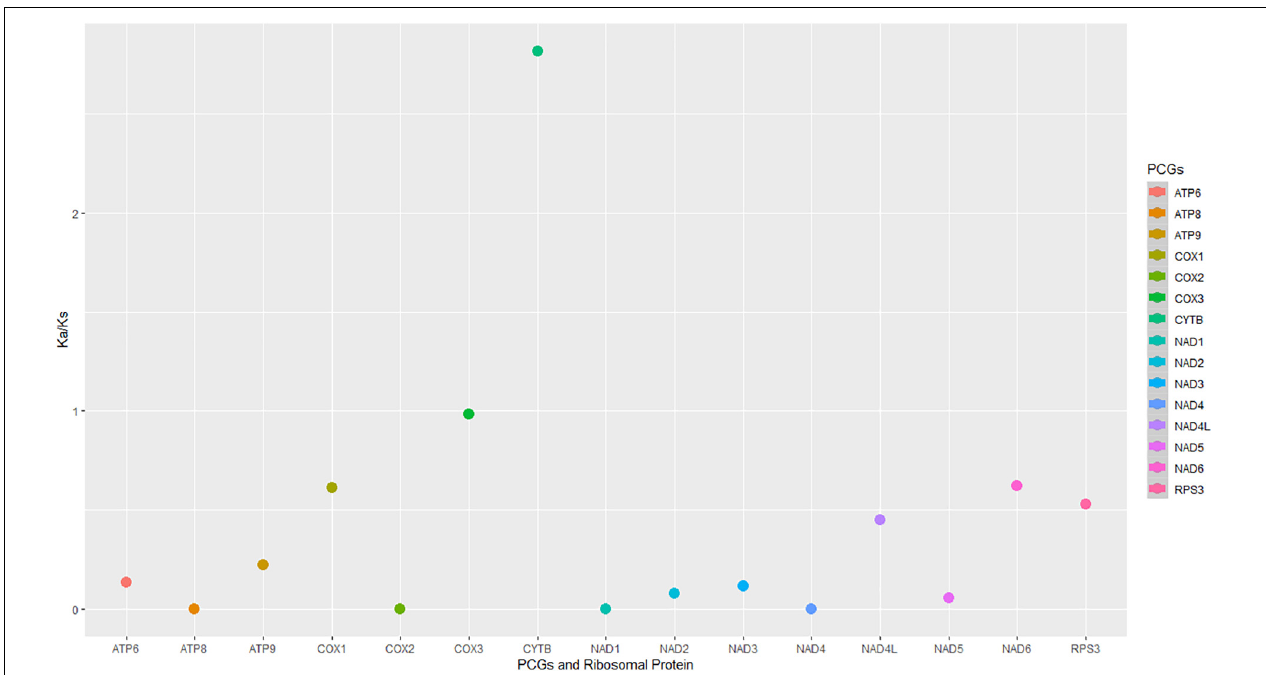
FIGURE 6 | The non-synonymous/synonymous mutation rates (Ka/Ks) were of the protein-coding regions and rps3 in the 16 mitogenomes from M. fructicola and M. laxa species.